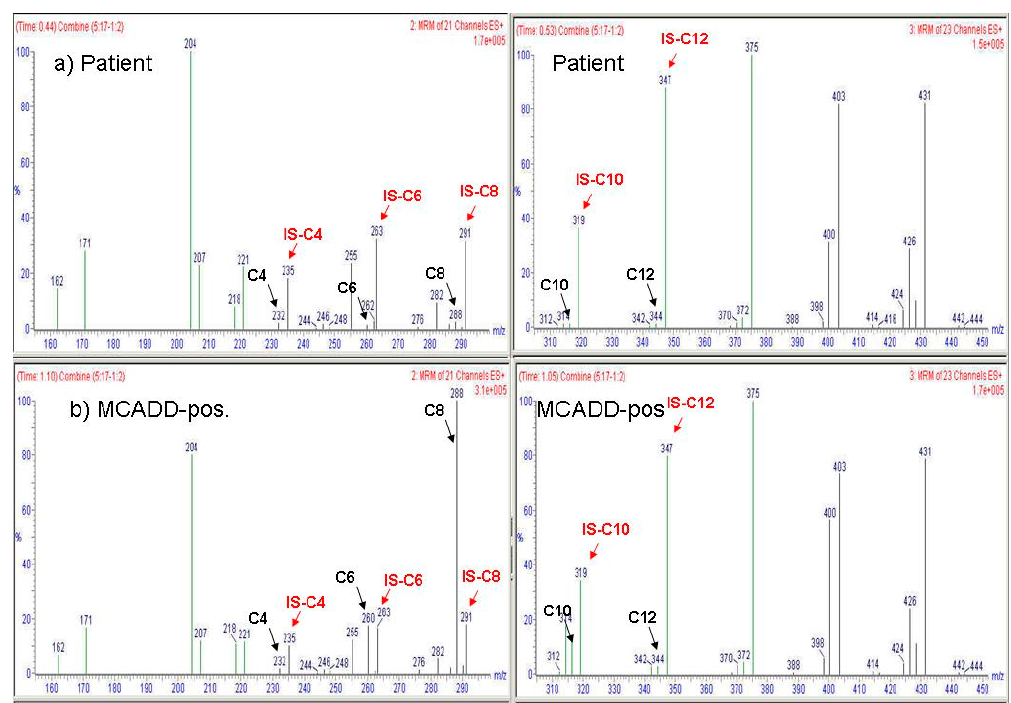
Figure 1. ( a ) Acylcarnitine profile of the patient (Fn); ( b ) Acylcarnitine profile of a typical MCADD-positive newborn screening result.